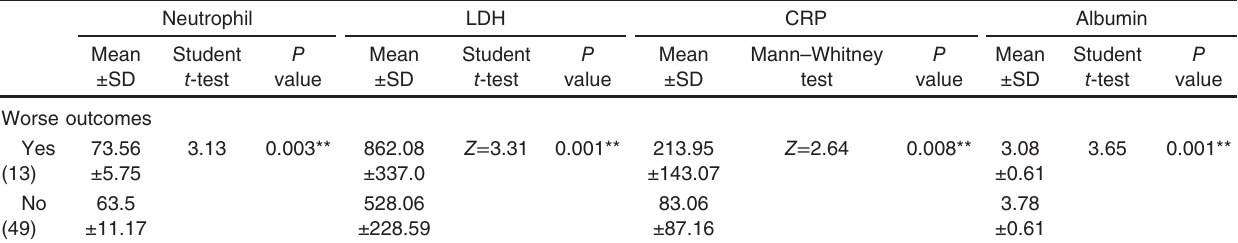
Table 4 Relation between laboratory markers (neutrophils, lactate dehydrogenase, C-reactive protein and albumin) and worse outcomes (ICU admission, mortality, and mechanical ventilation)